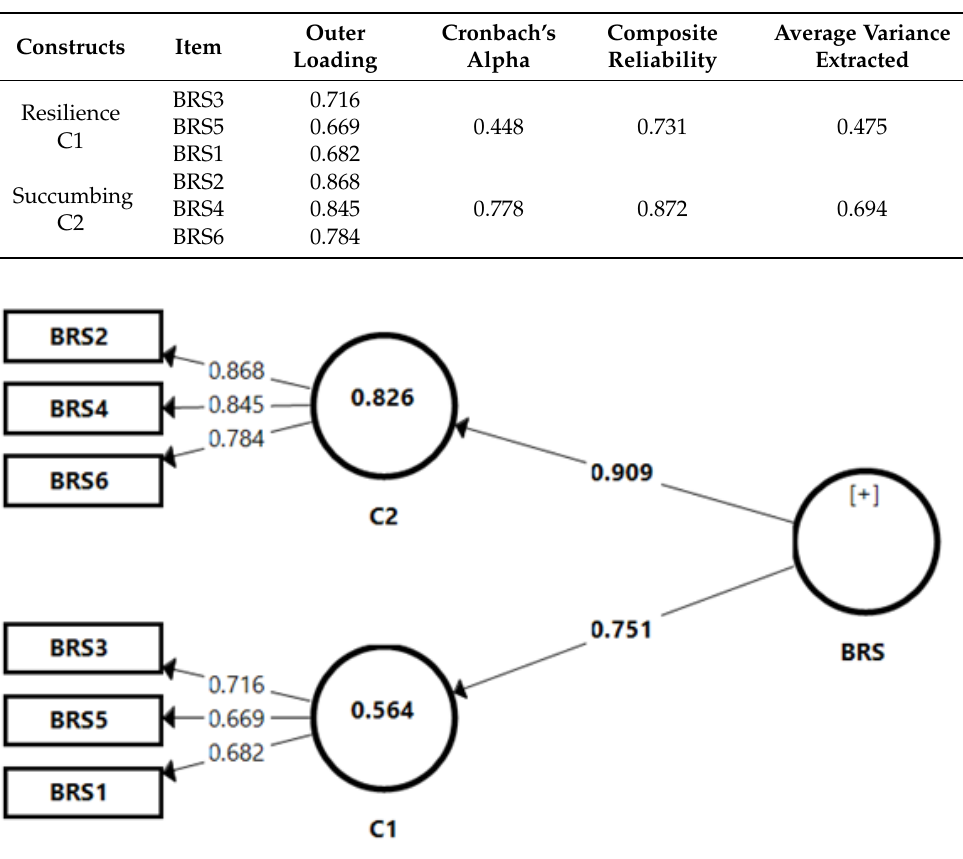
Table 3. Cronbach α, average variance extracted (AVE) values, and composite reliability (CR) among the two constructs.